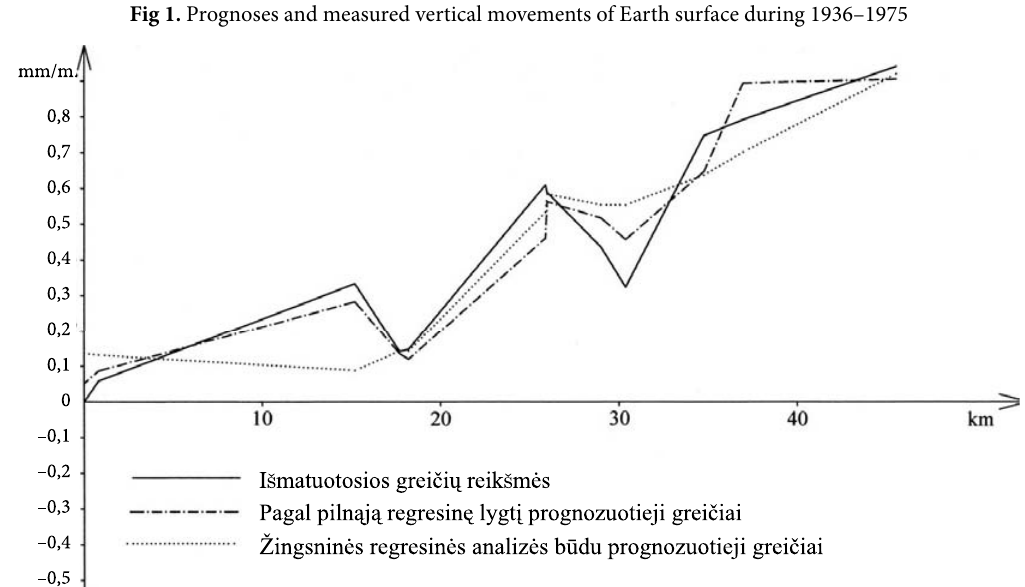
Fig 2. Prognoses and measured vertical movements of Earth surface during